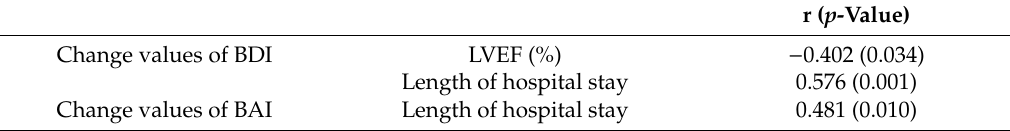
Table 6. Relationship between the change values of emotional distress and the baseline characteristics.